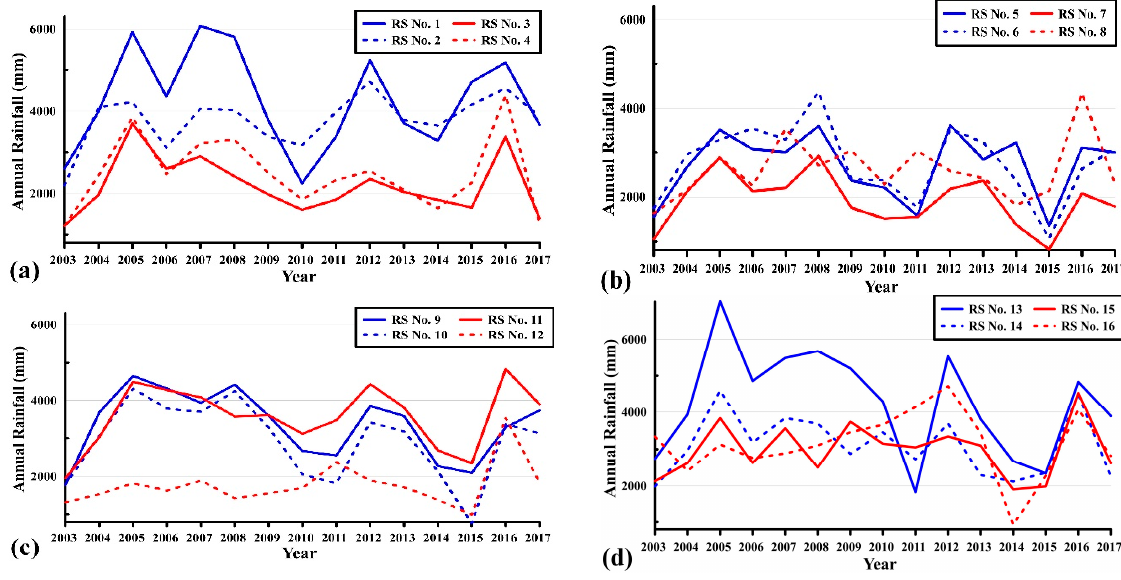
Figure 4. Temporal distribution of annual rainfall in the rainfall stations no. 1-4 ( a ), no. 5-8 ( b ), no. 9-12 ( c ), and no. 13-16 ( d ) in 2003–2017 in Taiwan.